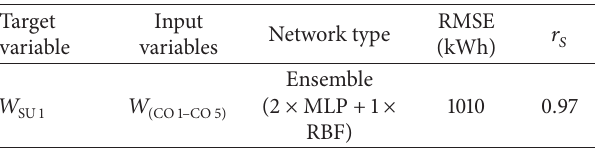
Table 10: Summary of the results for the calculation of the income of